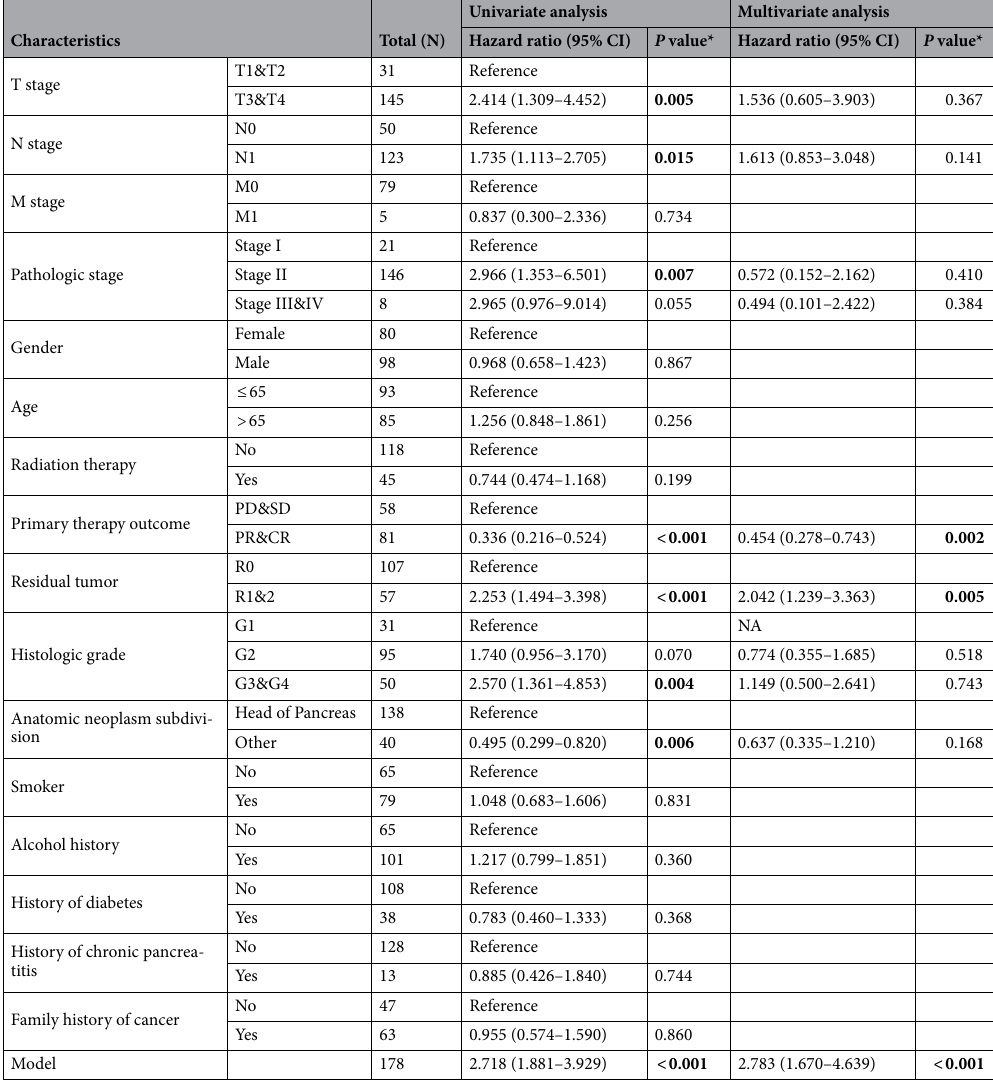
Table 7. The univariate and multivariate analysis for the PFI (TCGA-PAAD). PFI progress free interval, CI confidence interval, NA reference group or could not be evaluated. *Compared with each group (log-rank test or Omnibus test for univariate, Cox regression analysis with adjusted hazard for multivariate). p < 0.05 means statistically significant (highlighted in